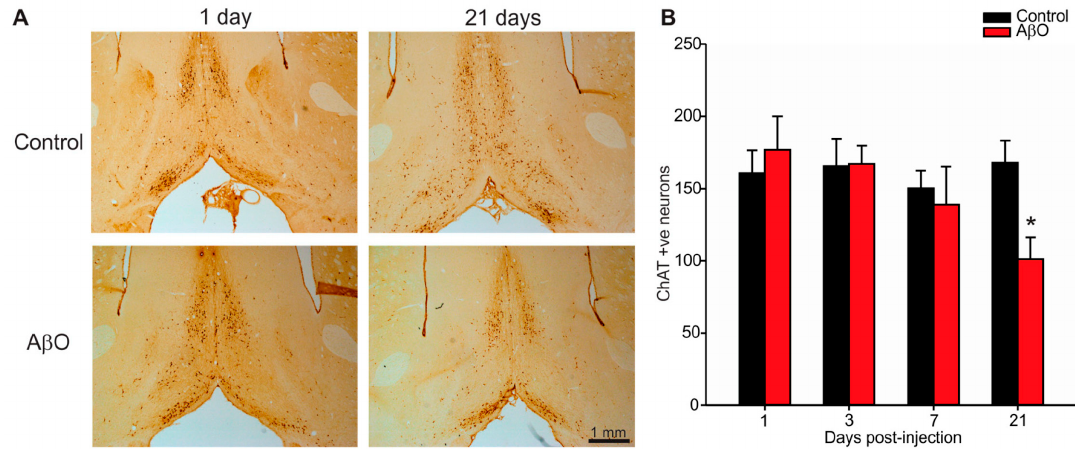
Figure 3. Immunolabelling for cholinergic neurons within the basal forebrain. Paraformaldehyde perfused rat brains were sectioned at 30 µm and stained with the ChAT antibody that specifically labels cholinergic neurons within the basal forebrain. ( A ) Photomicrographs of the basal forebrain in coronal rat brain sections from A β O-injected and PBS-injected (control) rats 1, and 21 days post-injection. Scale bar is 1 mm; ( B ) Quantification of cholinergic neuron cell counts from three adjacent tissue sections per animal. A β O-injected rats had significantly more ChAT labelling in the basal forebrain compared to controls 21 days post-injection. Data presented as group means ± SEM. * indicates statistical significance between A β O-injected and control rats using 2-way ANOVA followed by Tukey’s post hoc analysis, p < 0.05, n = 5 for each experimental group.